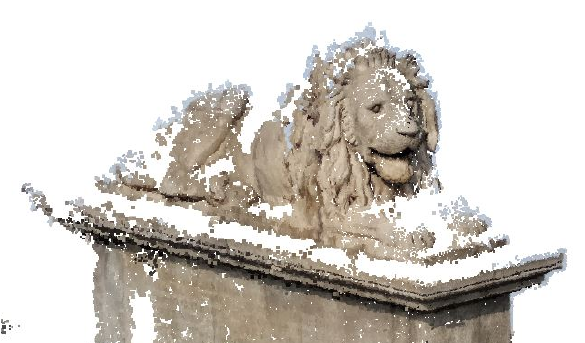
Figure 4. Reconstruction from smart phone